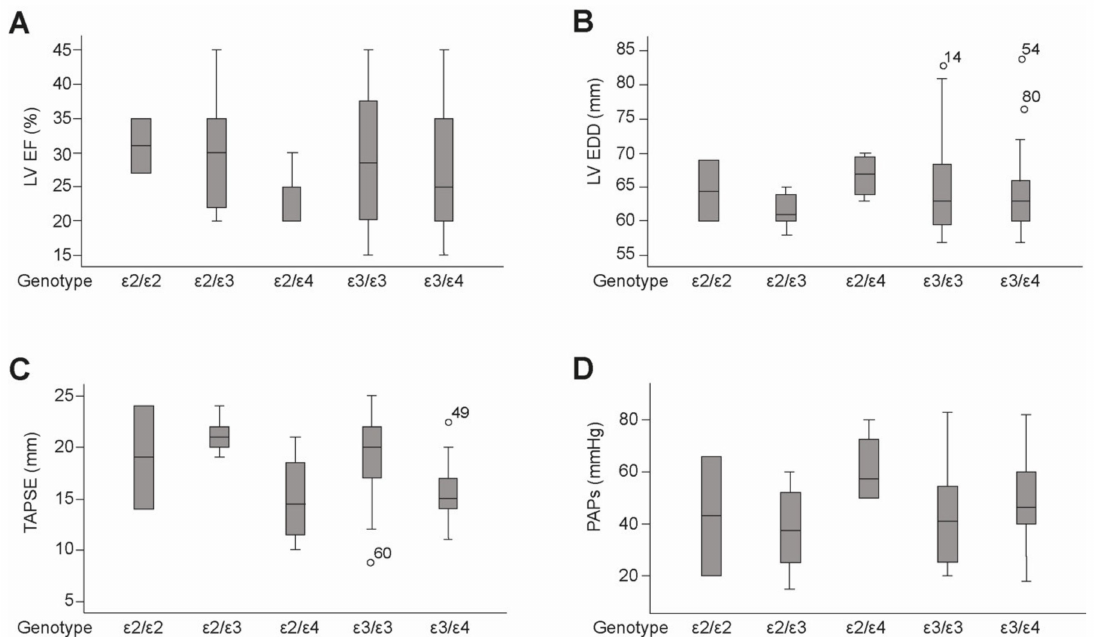
Figure 7. Functional parameters in different genotypes. ( A ) Left ventricular ejection fraction (LVEF), ( B ) left ventricular end-diastolic diameter (LVEDD), ( C ) tricuspid annular plane systolic excursion (TAPSE) and ( D ) and pulmonary arterial pressure